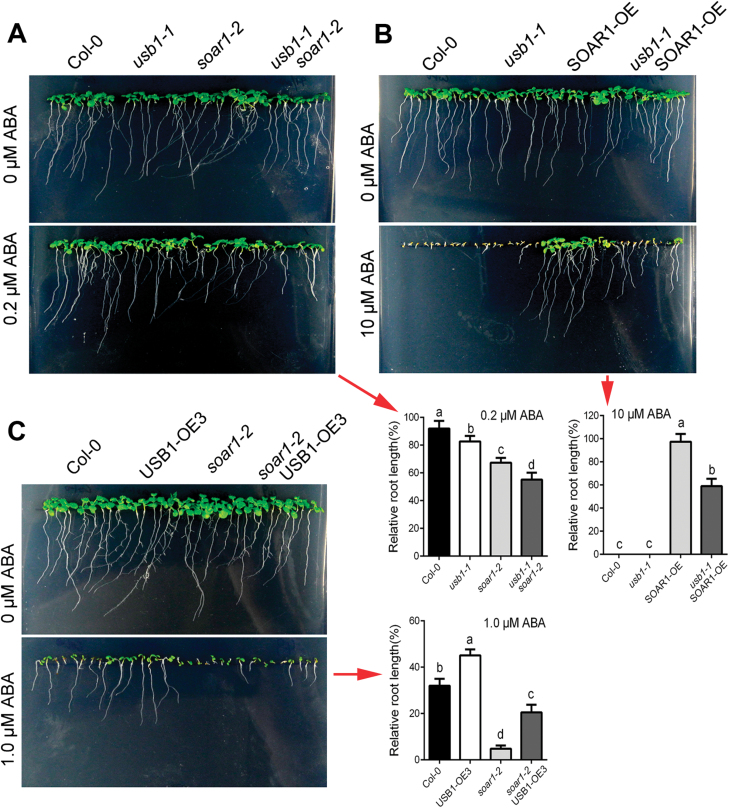
USB1 functionally interacts with SOAR1 in ABA-induced early seedling growth inhibition. (A) Seedling growth of the wild-type Col-0, usb1-1 and soar1-2 single mutants, and the usb1-1 soar1-2 double mutant in ABA-free (0 μΜ) and ABA-containing (0.2 μΜ) medium 10 d after stratification at 4 °C for 3 d. (B) Seedling growth of wild-type Col-0, usb1-1, the SOAR1 overexpression line OE6 (SOAR1-OE), and SOAR1-OE under the usb1-1 background(usb1-1 SOAR1-OE) in ABA-free (0 μM) and ABA-containing (10μM) medium. (C) Seedling growth of wild-type Col-0, soar1-2, and USB1-OE3 under the soar1-2 background (soar1-2 USB1-OE3) in ABA-free (0 μM) and ABA-containing (1.0 μM) medium. In (A–C), the histograms (indicated by red arrows) show statistical analysis of the relative root length of the corresponding different genotypes, and the relative root length of each genotype grown on ABA-containing MS medium was normalized relative to the value of the corresponding genotype at 0 μΜ ABA, which was taken as 100%. Each value is the mean ±SE of five biological determinations, and different letters indicate significant differences at P<0.05 (Duncan’s multiple range test) when comparing values within the same ABA concentration.